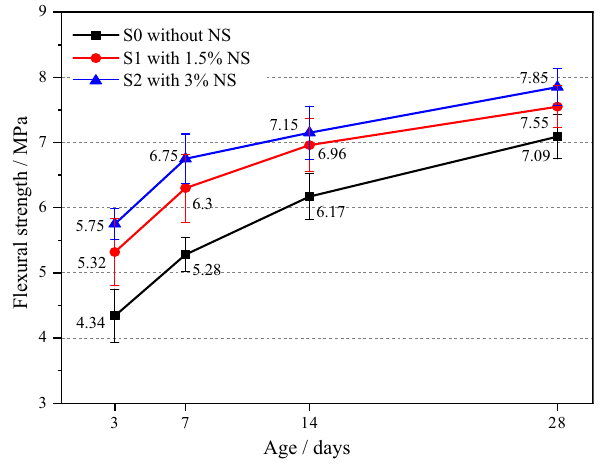
Figure 8: Development of fl exural